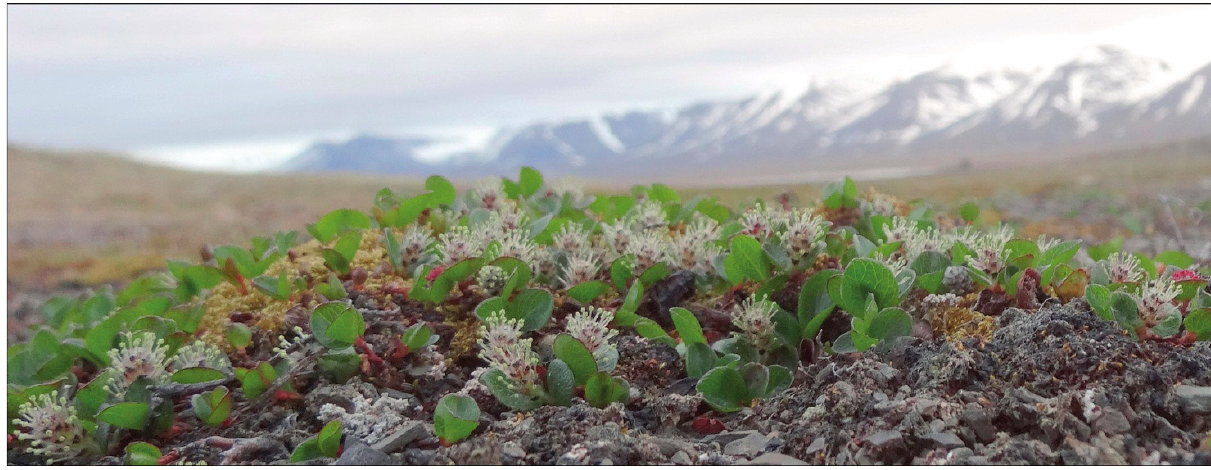
Figure 3. Photo of general flowering of catkins of Salix polaris